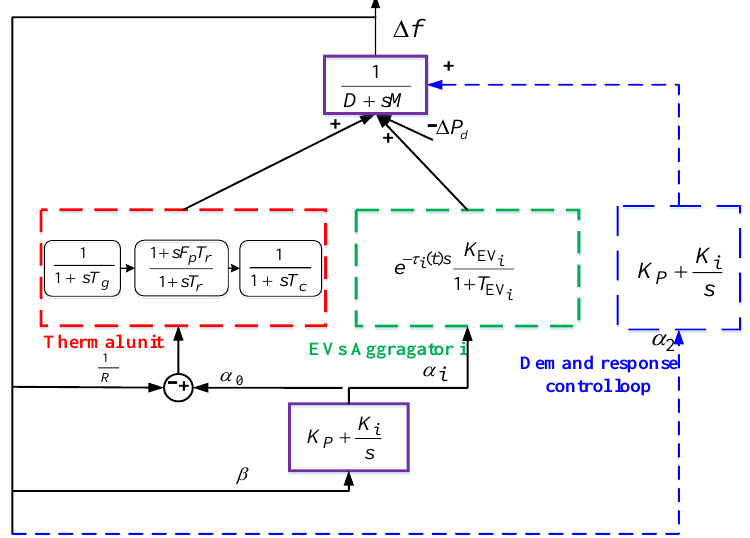
Figure 1. Schematic of the proposed strategy for the delay-dependent stability analysis.